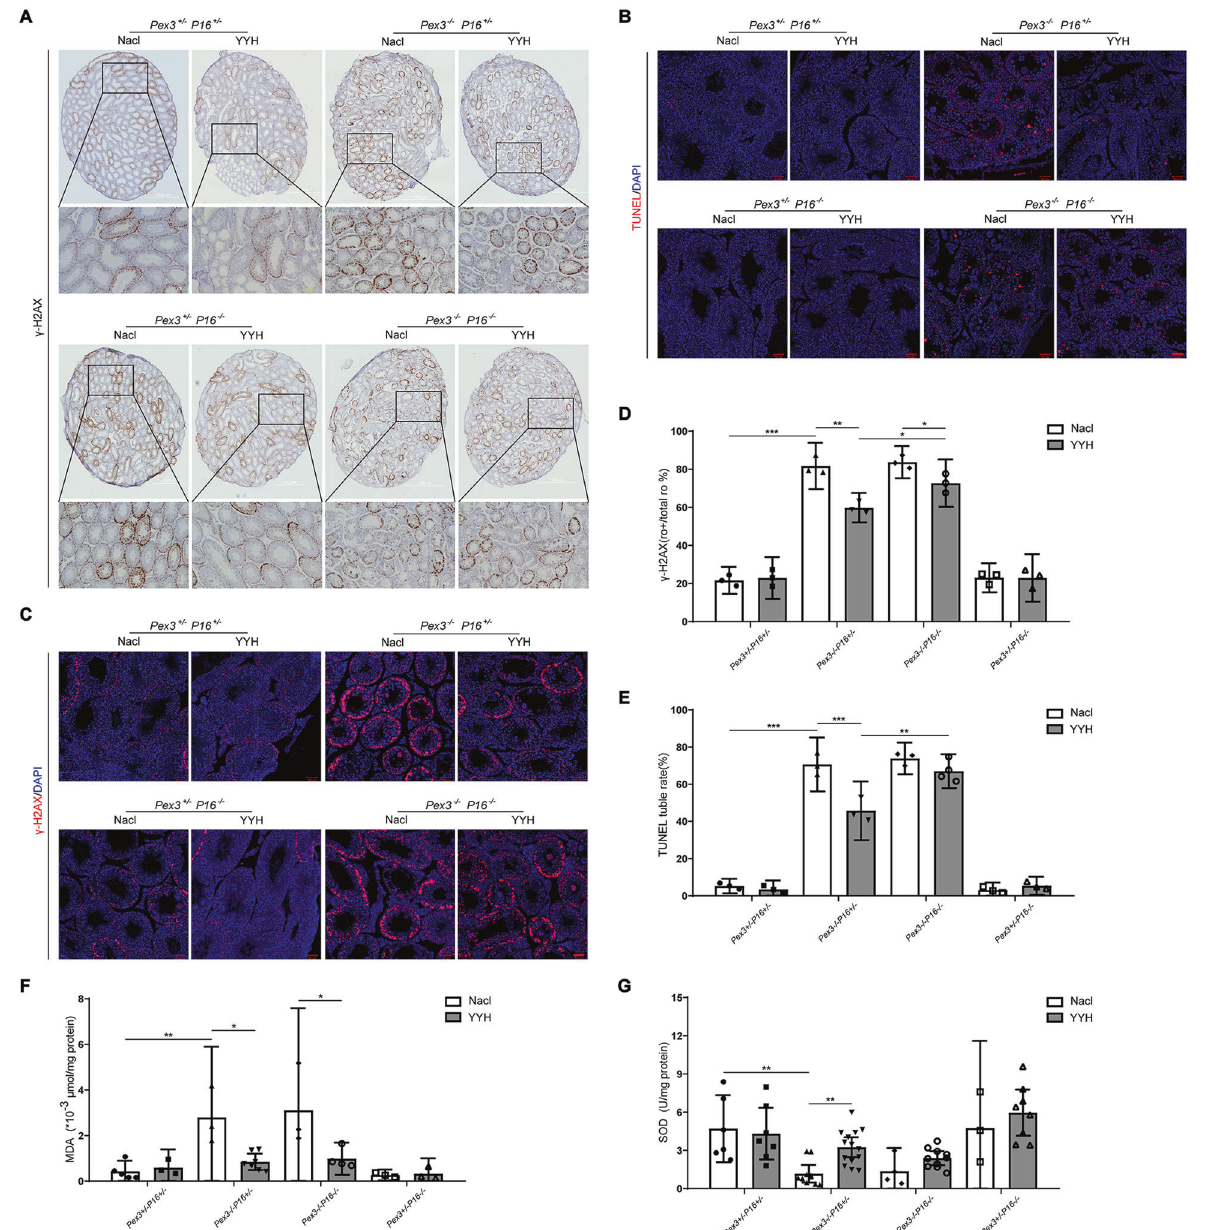
Fig. 8 Effects of YYH supplementation on OS levels in testicular tissues of mice with different genotypes. ( n = 3 – 6). A γ -H2AX immunohistochemistry in testicular sections. Scale bars: 100 μ m. B TUNEL staining of testicular sections. Scale bars: 50 μ m. C γ -H2AX immuno fl uorescence in testicular sections. Scale bars: 50 μ m. D Rate of γ -H2AX-positive luminal cells. E Rate of TUNEL-positive luminal cells. F MDA level. G SOD